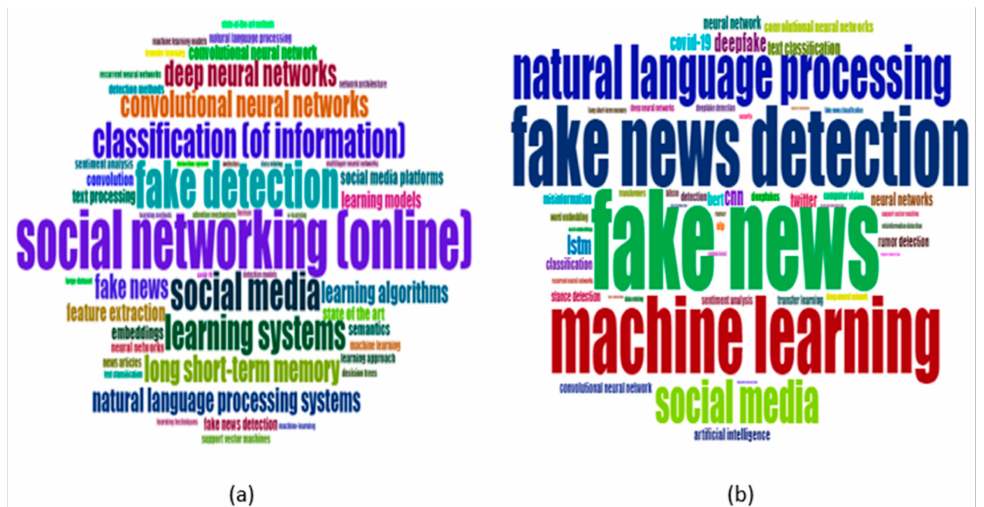
Figure 14. Word cloud: ( a ) keywords plus; ( b ) authors’